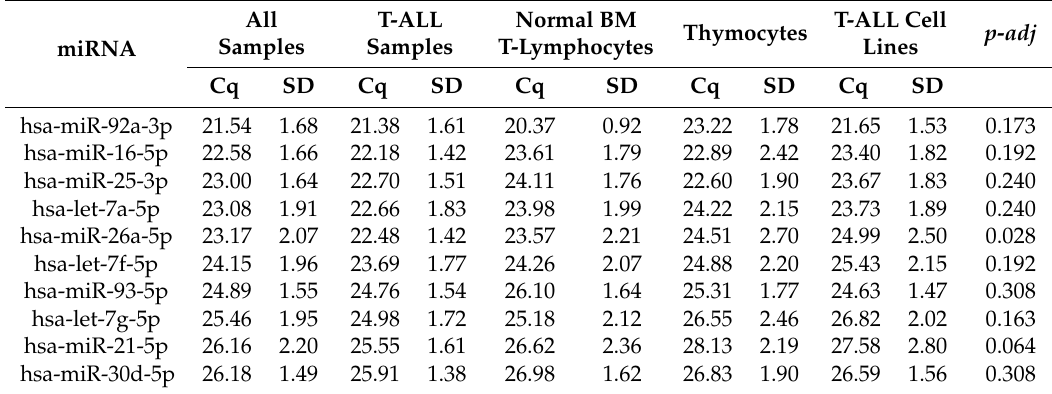
Cq and SD values represent mean values across biological replicates. Significance of Cq differences between biological groups was tested with one-way ANOVA and Benjamini and Hochberg correction to adjust for multiple testing ( p - adj ). BM, bone marrow.